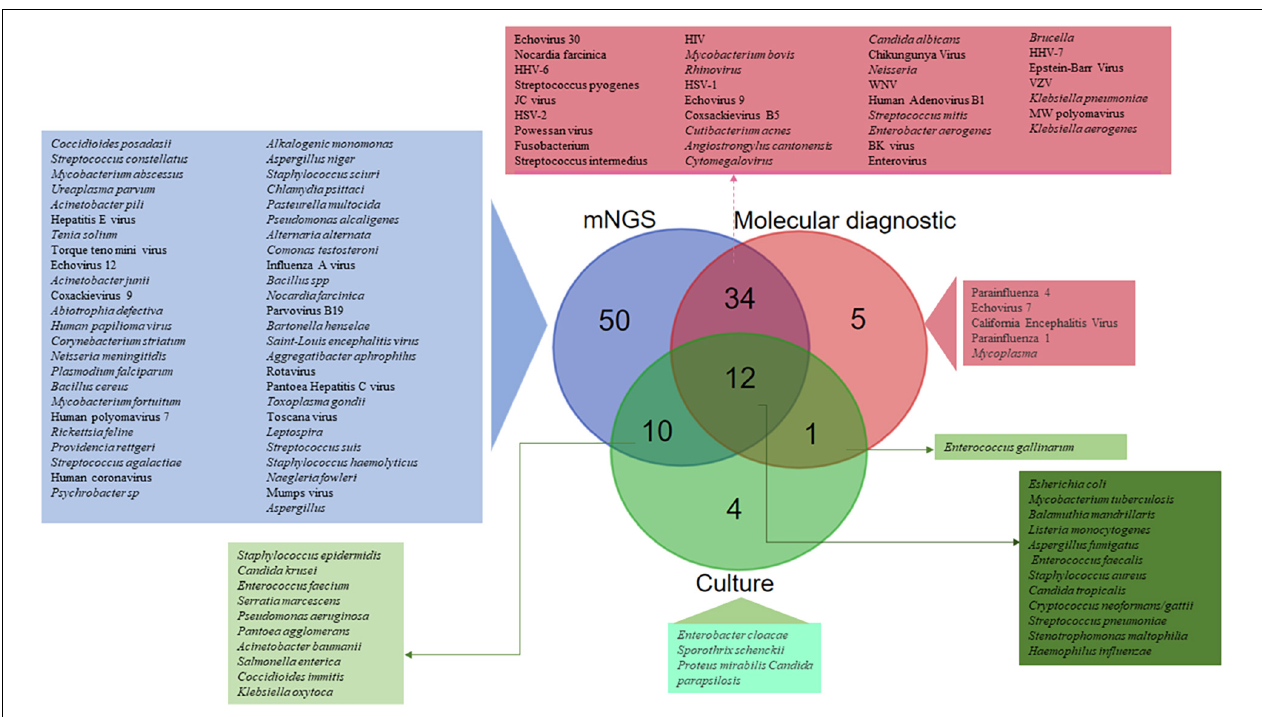
FIGURE 4 | SAM pathogens identified by routine molecular diagnosis, culture, and metagenomic next generation sequencing (mNGS). A total of 116 different microorganisms were identified, including 50 (43.1%) only by mNGS, 43 by both routine molecular diagnosis and mNGS, 12 by culture, mNGS and routine molecular diagnosis, 10 by culture and mNGS, five only by routine molecular diagnosis, four only by culture, and one only by culture and routine molecular